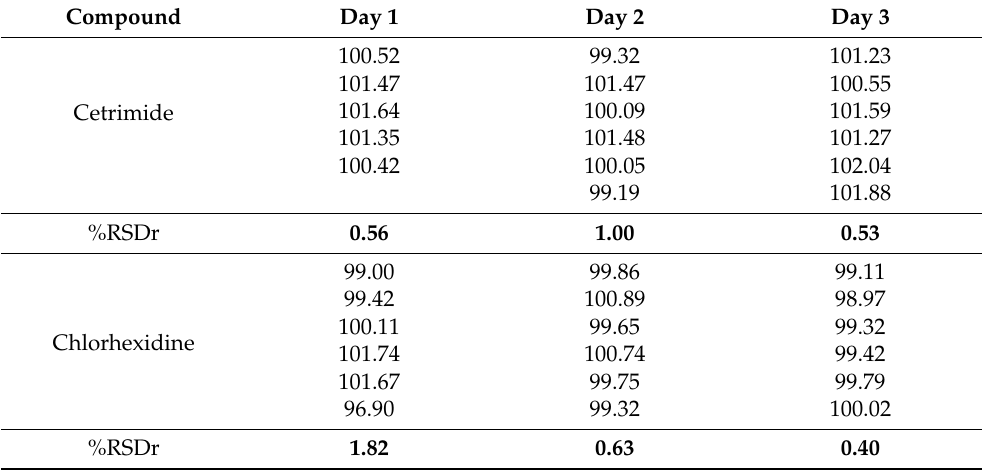
Table 5. Results of repeatability for an interval of 3